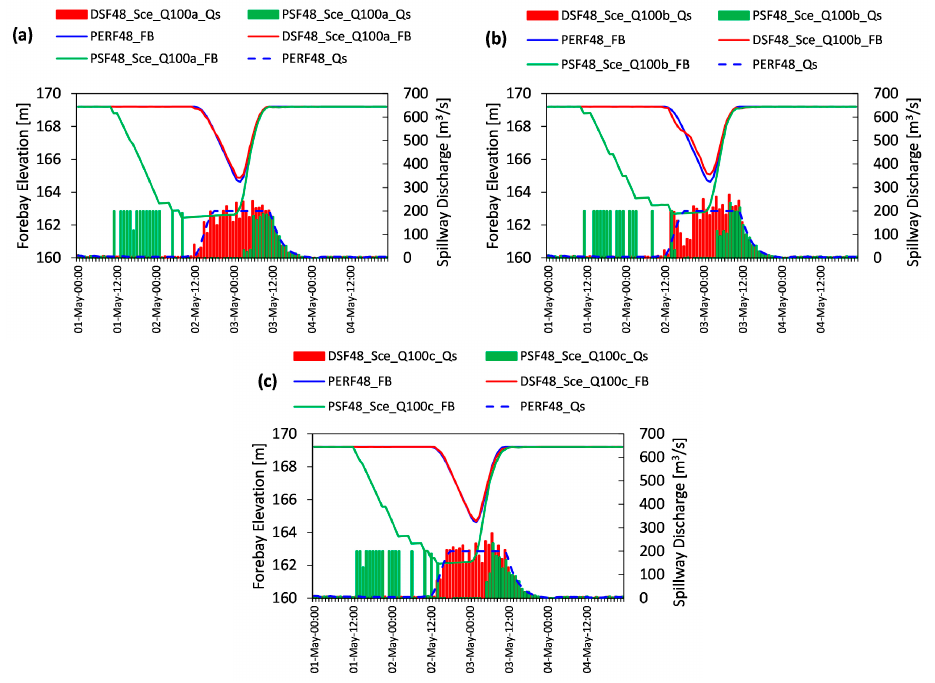
Figure 12. Comparison of deterministic (perfect and DSF) and stochastic (PSF) closed-loop MPC results with different forecast scenarios for Q 100 : ( a ) Sce-Q100a; ( b ) Q100-Sceb; ( c ) Q100-Scec. Table 3. Peakflow assessment of deterministic and stochastic closed-loop MPC results for different inflow conditions with forecast horizons of 48